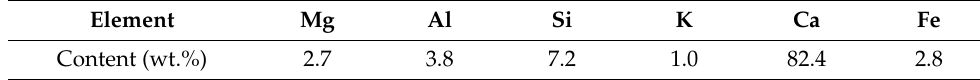
Table 1. Elemental metal composition of limestone (wt.%).